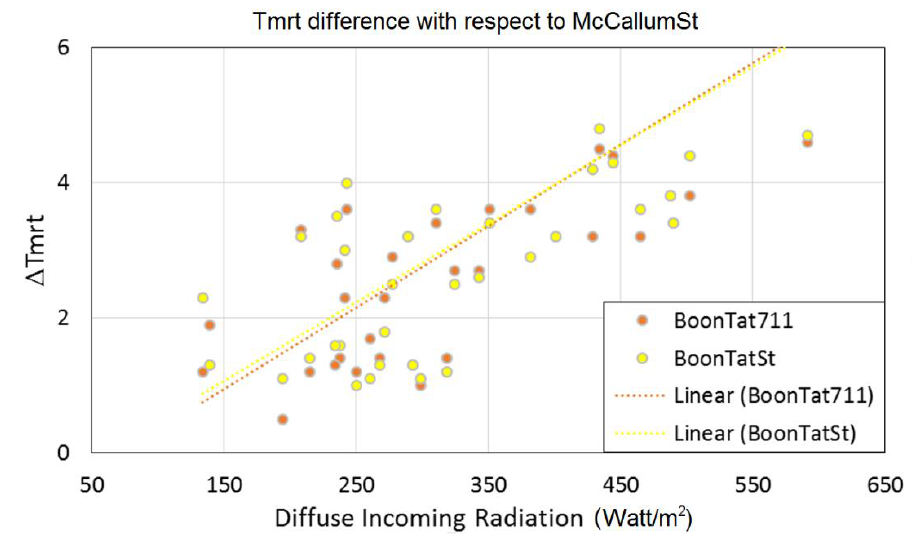
Figure 12. Relation between diffuse solar radiation (above the urban canopy) and the T mrt difference (∆T mrt in °C) between a low SVF site (BoonTatSt/BoonTat711) and a high SVF site (McCallumSt) in the period 12:00 to 13:00 during the wet NE-Monsoon season (1 December 2019 to 13 January 2020) and under dry conditions.